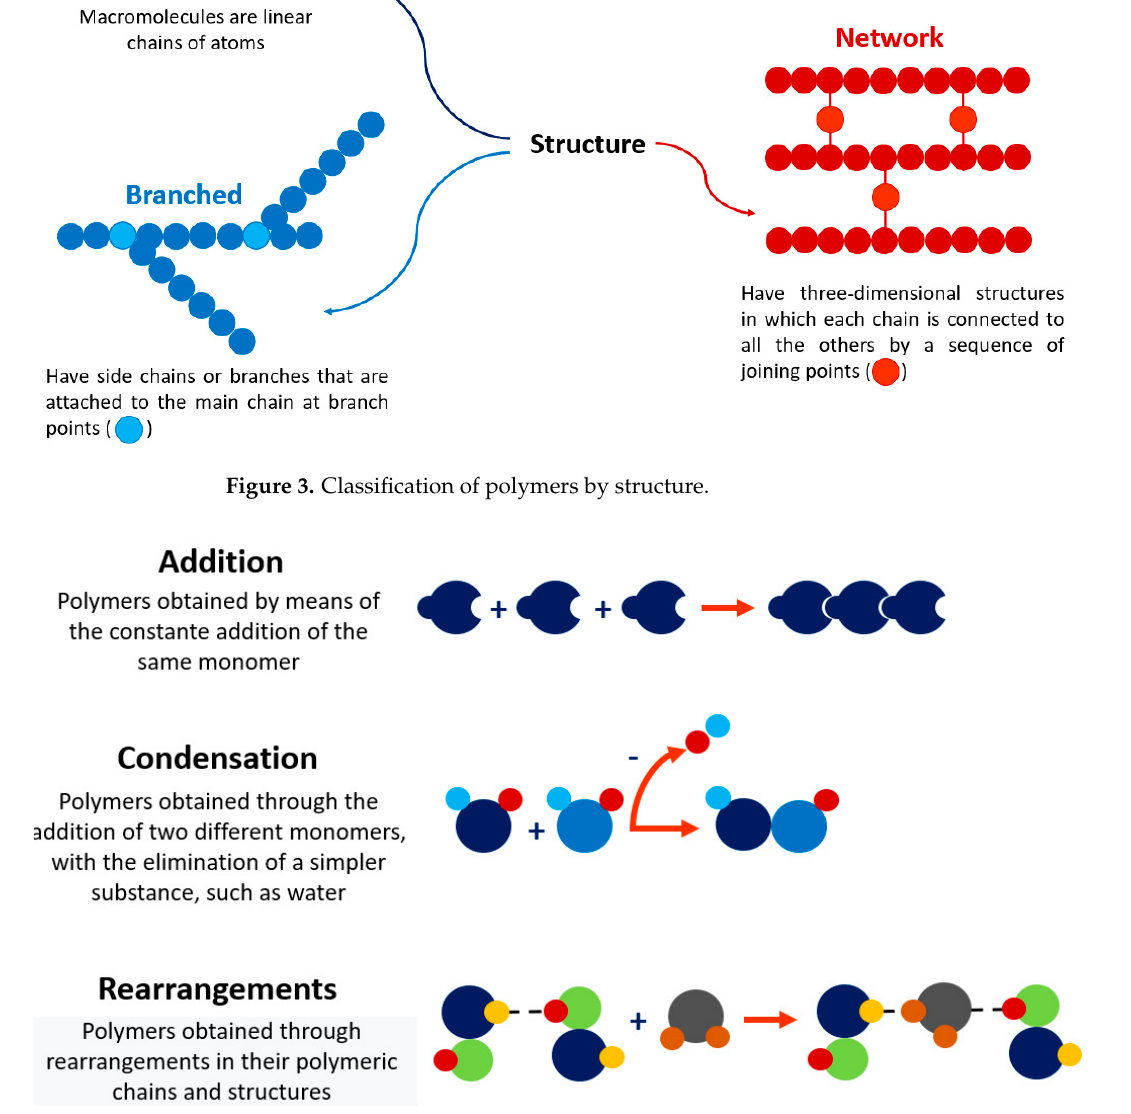
Figure 4. Description and illustration of methods for obtaining polymers.